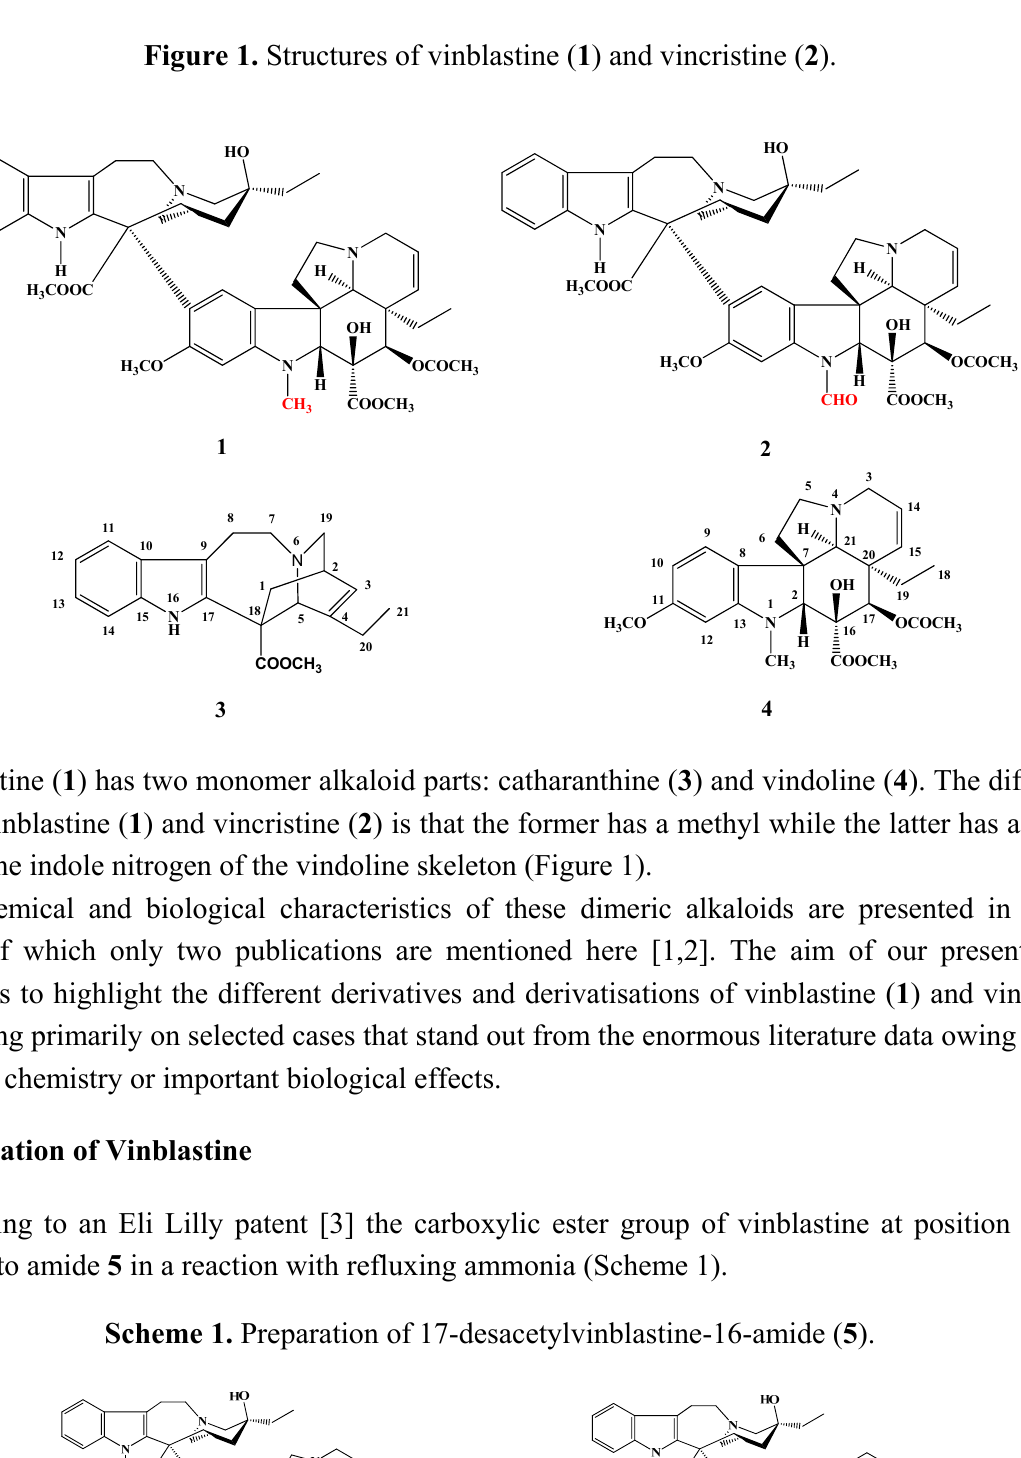
Figure 1. Structures of vinblastine ( 1 ) and vincristine ( 2